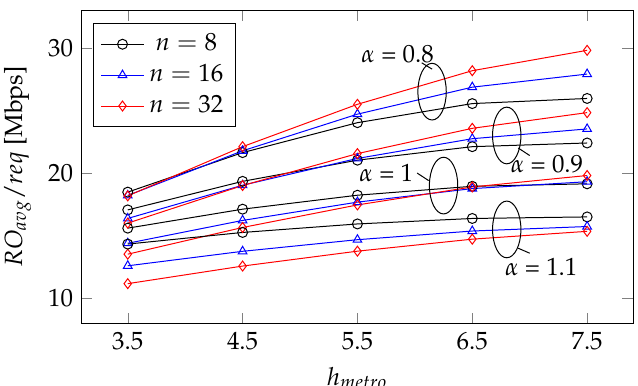
Figure 5. RO avg / req for cache deployments with different numbers of AMEN caches utilized in the network for different values of α with respect to h metro , the average hop-distance between the MCEN cache and end-users.